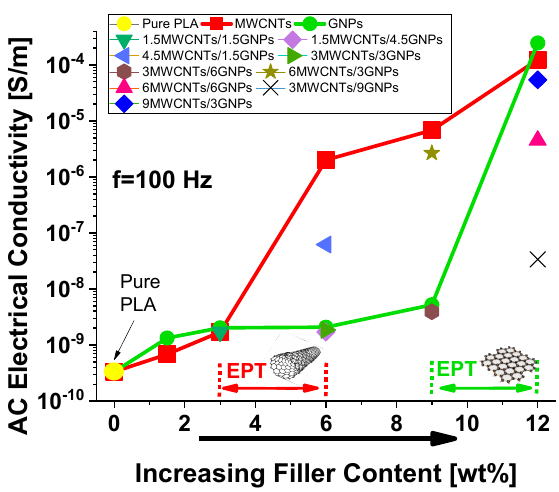
Figure 11. AC electrical bulk conductivity evaluated at frequency of 100 Hz and electrical percolation threshold for all formulations investigated in the present study.